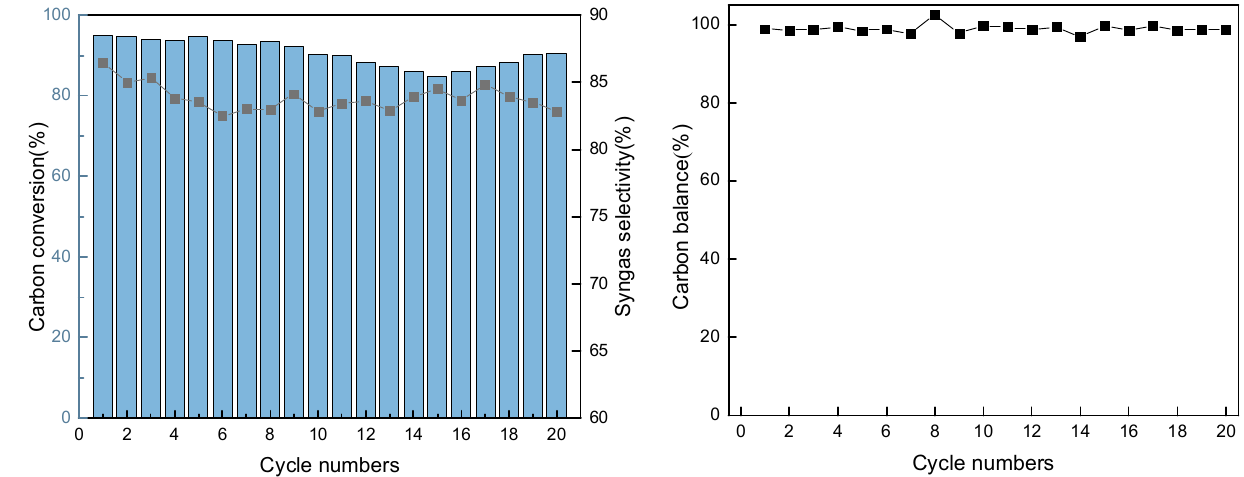
show that the Ni 2 FeO 4 oxygen carrier addition with ZrO 2 can be well applied to the CLG of Ningxia bituminite coal to prepare high-quality syngas with good cyclic reaction per- formance . Figure 7. E ff ect of steam addition on CLG. Figure 7. Effect of steam addition on CLG.